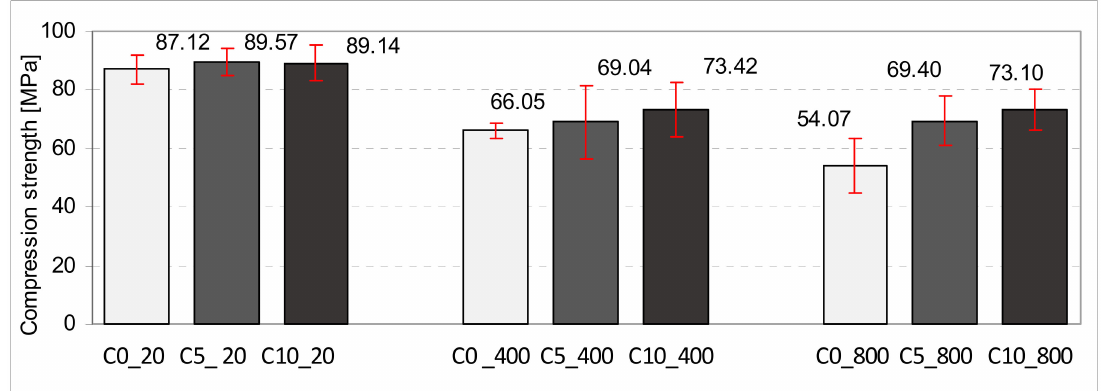
Figure 9. The average values with standard deviations of compression strength of cubic samples containing calcium aluminate